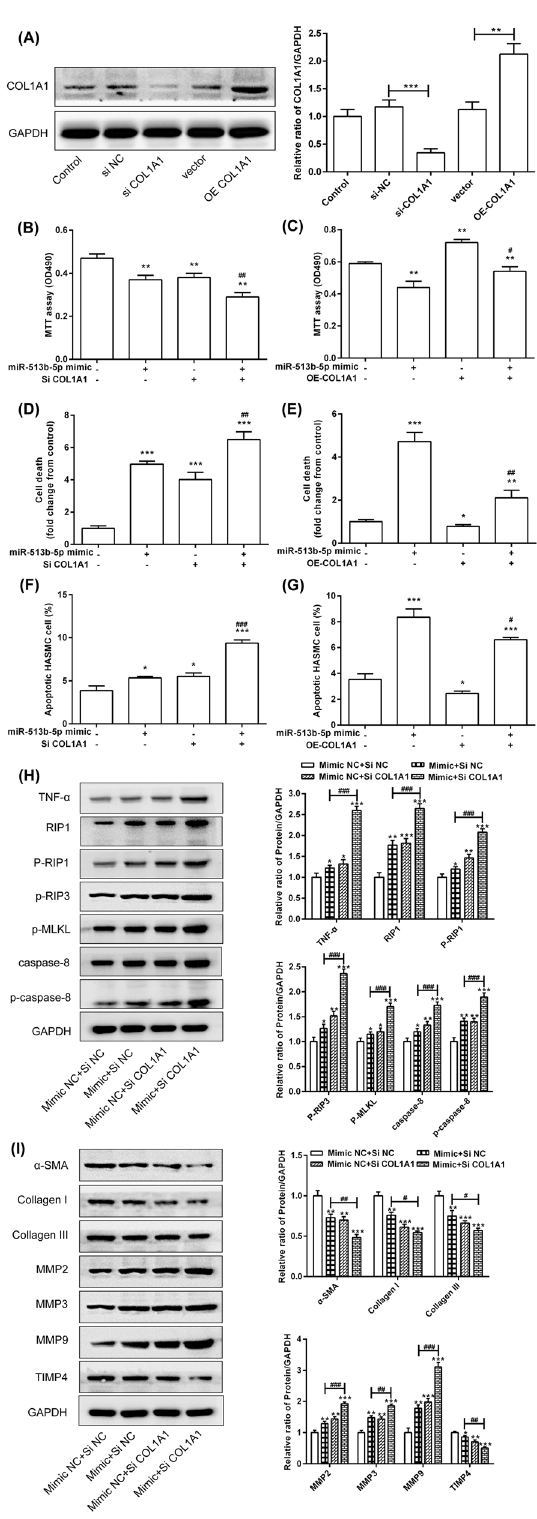
Figure 4. COL1A1 rescued the effect of miR-513b-5p on viability of HASMCs by the RIP1-RIP3-MLKL and MMP pathways. ( A ) The protein and mRNA expression was detected after COL1A1 interference and over-expression. ( B ) Interference with COL1A1 enhanced the inhibitory effect of miR-513b-5p on the cell proliferation. ( C ) Over-expression of COL1A1 inhibited the inhibitory effect of miR-513b-5p on the cell proliferation. ( D ) Interference with COL1A1 enhanced the induction of cell death by miR-513b-5p. ( E ) Over-expression of COL1A1 inhibited the induction of cell death by miR-513b-5p. ( F ) Interference with COL1A1 enhanced the induction of cell apoptosis by miR-513b-5p. ( G ) Over-expression of COL1A1 inhibited the induction of cell apoptosis by miR-513b-5p. COL1A1 regulated the expression of related proteins in the ( H ) RIP1-RIP3-MLKL and ( I ) MMP pathways. All data presented as the mean ± standard deviation, and three independent experiments were carried out. Compared with mimic NC + siRNA NC group, * p < 0.05, ** p < 0.01, and *** p < 0.001. Compared with miR-513b-5p mimic + siRNA NC group, # p < 0.05, ## p < 0.01, and ### p < 0.001. One-way ANOVA with two-sided LSD post hoc test was